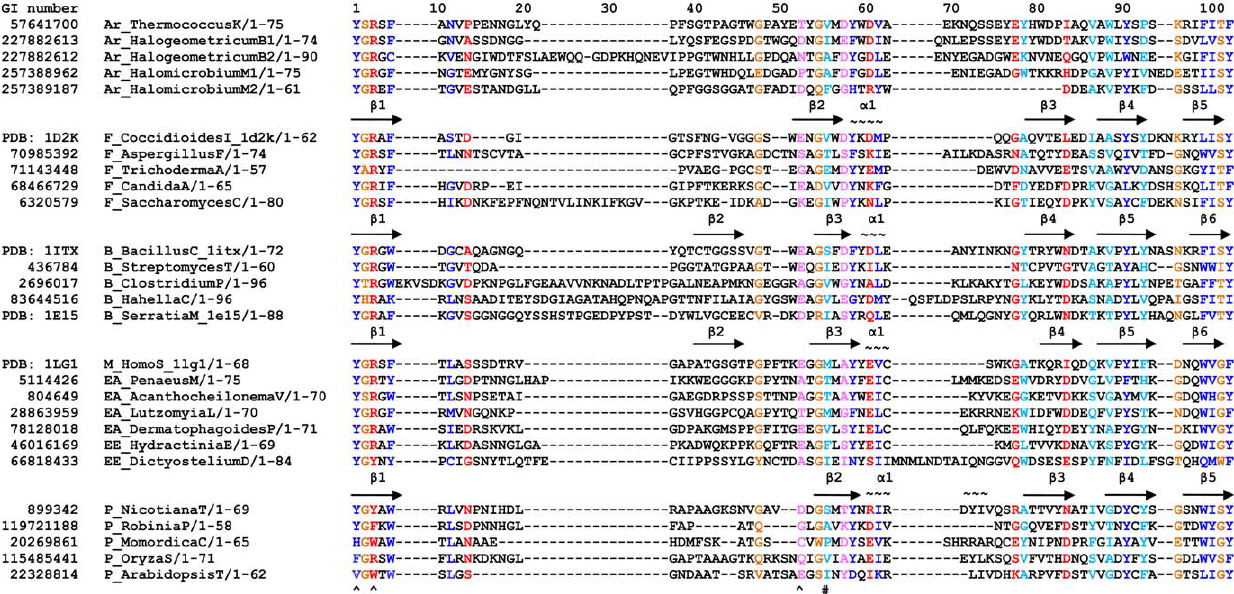
Figure 2. Structure-based multiple sequence alignment of the CID. Hydrophobic positions with high conservation ( C (i) $ 0.45) are coloured in blue and positions with moderate conservation (0.35 # C (i) , 0.45) are coloured in light blue. Hydrophilic positions with high conservation are coloured in red and positions with moderate conservation are coloured in pink. Neutral positions with high conservation containing mostly glycine, alanine, or proline are coloured in brown, while positions with moderate conservation are not highlighted. ‘ , ’ and ‘ R ’ indicate the sequences in a - helices and b -strands, respectively. The secondary structure of tobacco chitinase CID was predicted by the program of PSIPRED. ‘ ˆ ’ and ‘ # ’ represent the positions which form hydrogen bonding and the hydrophobic interaction with the substrate, respectively. Smaller alignments can be found in the following references: [24,31,33,78]. The sequences from the following species are listed in the alignment: T. kodakarensis KOD1, Halogeometricum borinquense DSM 11551, Halomicrobium mukohataei DSM 12286, C. Immitis , A. fumigatus , Trichoderma atroviride , C. albicans SC5314, S. cerevisiae , B. circulans , Streptomyces thermoviolaceus , Clostridium paraputrificum , Hahella chejuensis KCTC 2396, S. marcescens , Homo sapiens , Penaeus monodon , Acanthocheilonema viteae , Lutzomyia longipalpis , Dermatophagoides pteronyssinus , Hydractinia echinata , Dictyostelium discoideum AX4, Nicotiana tabacum , Robinia pseudoacacia , Momordica charantia , Oryza sativa , and Arabidopsis thaliana . The full genus name and the first letter of species name are shown for each organism in the figure. If two sequences are from one species, a number is added after the species name. All the sequences were obtained from the protein database at the NCBI. Abbreviations: Ar, Archaea; B, Bacteria; F, Fungi; P, Plantae; EE, early eukaryotes; EA, early Animalia; M,